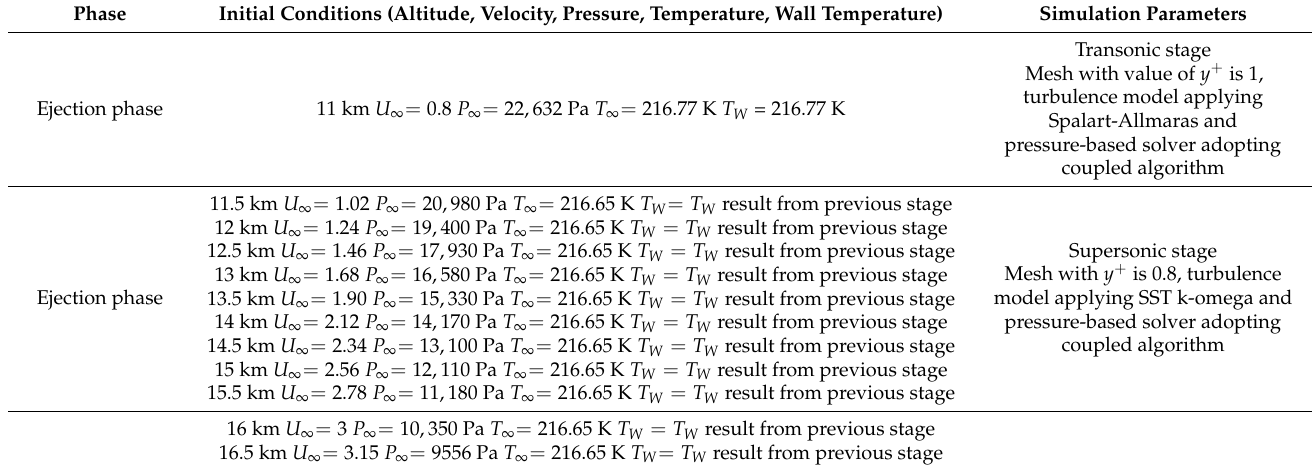
Table 13. Simulation scheme for aerodynamic heat prediction of RBCC scramjet-propelled vehicle in the flight path. Phase Initial Conditions (Altitude, Velocity, Pressure, Temperature, Wall Temperature) Simulation Parameters Ejection phase